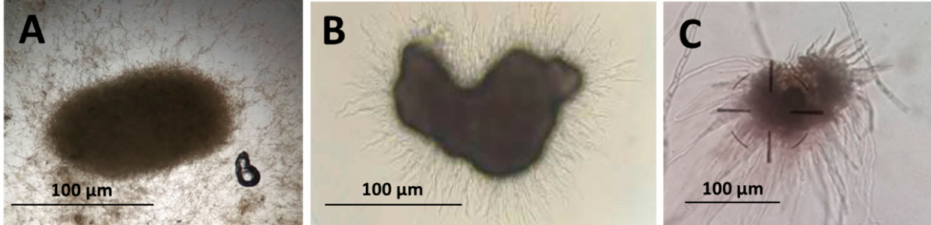
Figure 1. Microsclerotia of Metarhizium sp. observed after 10 days in liquid fermentation at 28 ◦ C and 300 rpm: ( A ) microsclerotium of M. robertsii EAMa 01/158-Su strain; ( B ) microsclerotium of M. brunneum EAMb 09/01-Su strain; ( C ) microsclerotium of M. brunneum EAMa 01/58-Su strain. The photomicrograph was taken at 100 × magnification, using an optical microscope (Motic BA400, Barcelona, Spain) and a digital camera (Leica DFC 450, Barcelona,